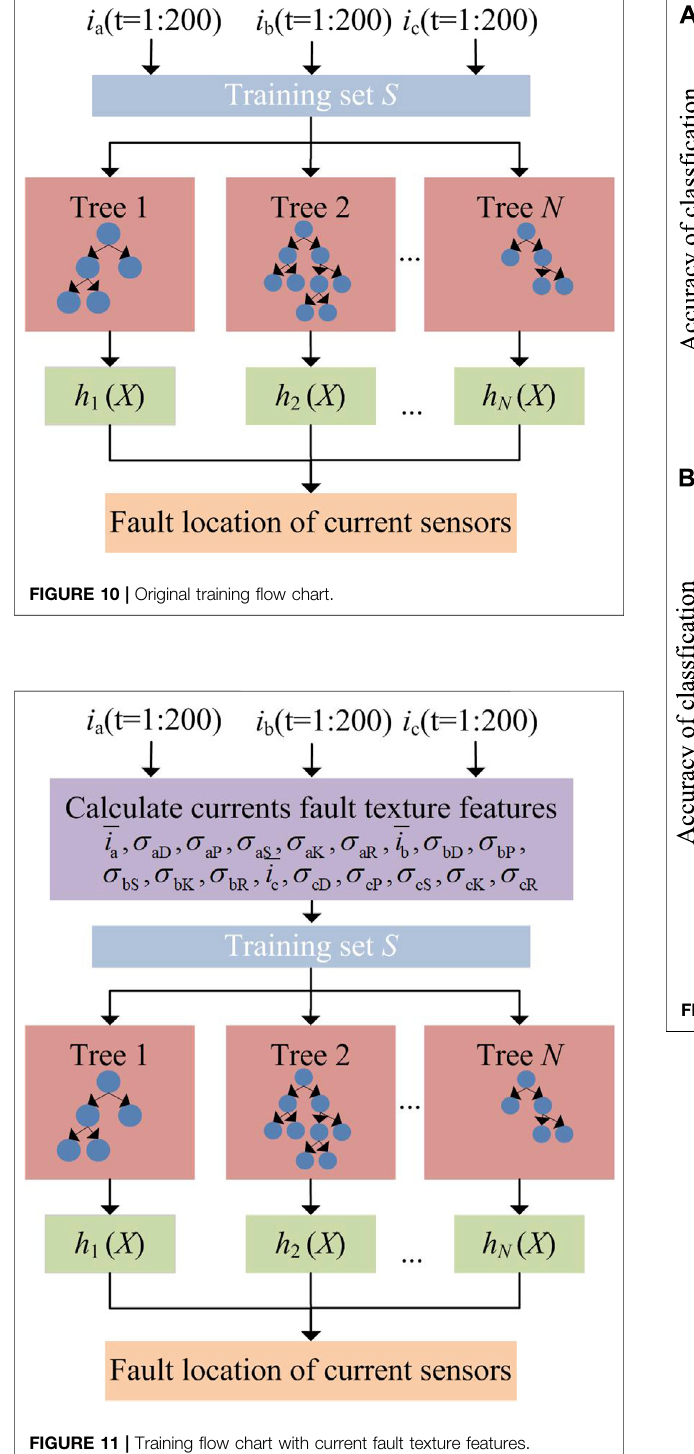
FIGURE 11 | Training fl ow chart with current fault texture features.